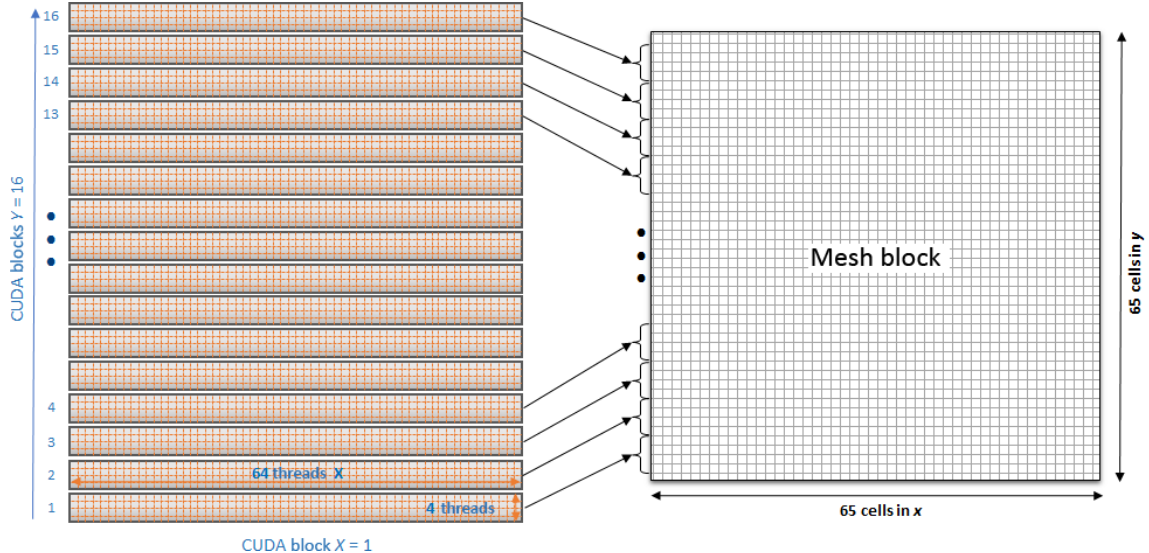
Figure 7. Mesh-block computation using CUDA kernels. Each CUDA block is made of 64 × 4 threads and computes a portion of the mesh block. One CUDA thread computes one mesh block cell.